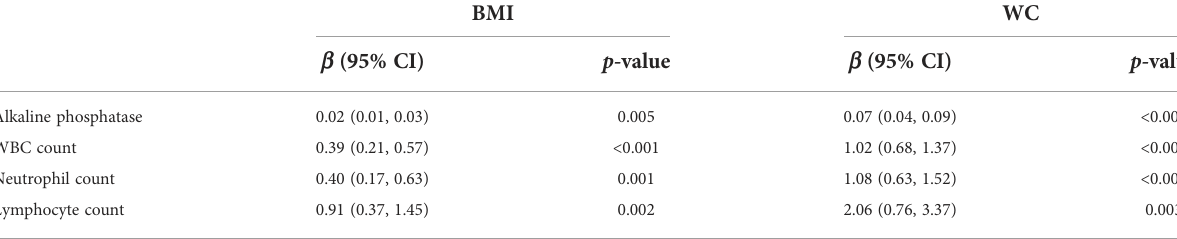
TABLE 4 Multiple linear regression associations of in fl ammatory markers with anthropometric parameters in